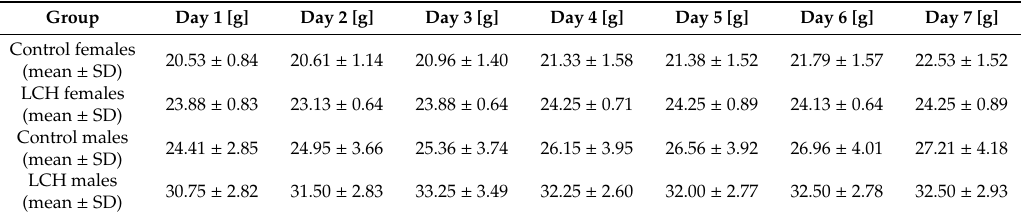
Table 1. Body mass changes in the